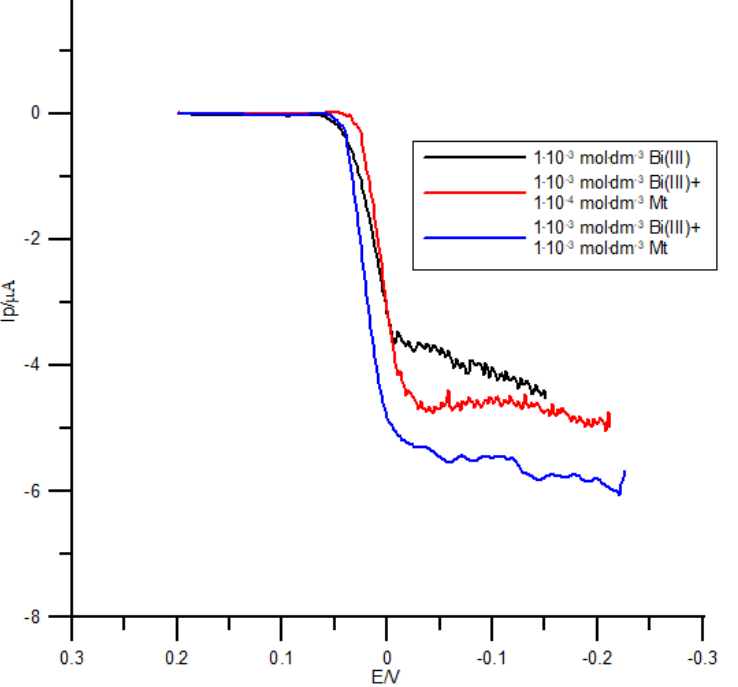
Figure 4. Direct current (DC) voltammograms of 1 × 10 −3 mol dm −3 Bi(III) electroreduction in 1 mol dm −3 chlorate(VII) solution in the presence of methionine. The concentration of methionine is given in the plot. The step potential is 2 mV.